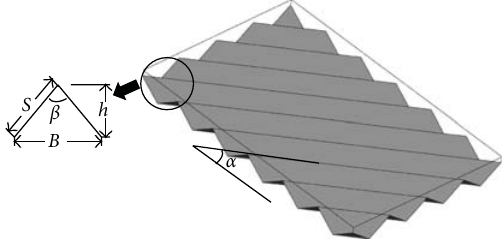
Figure 1: Elementary geometry details of the corrugated sheet of